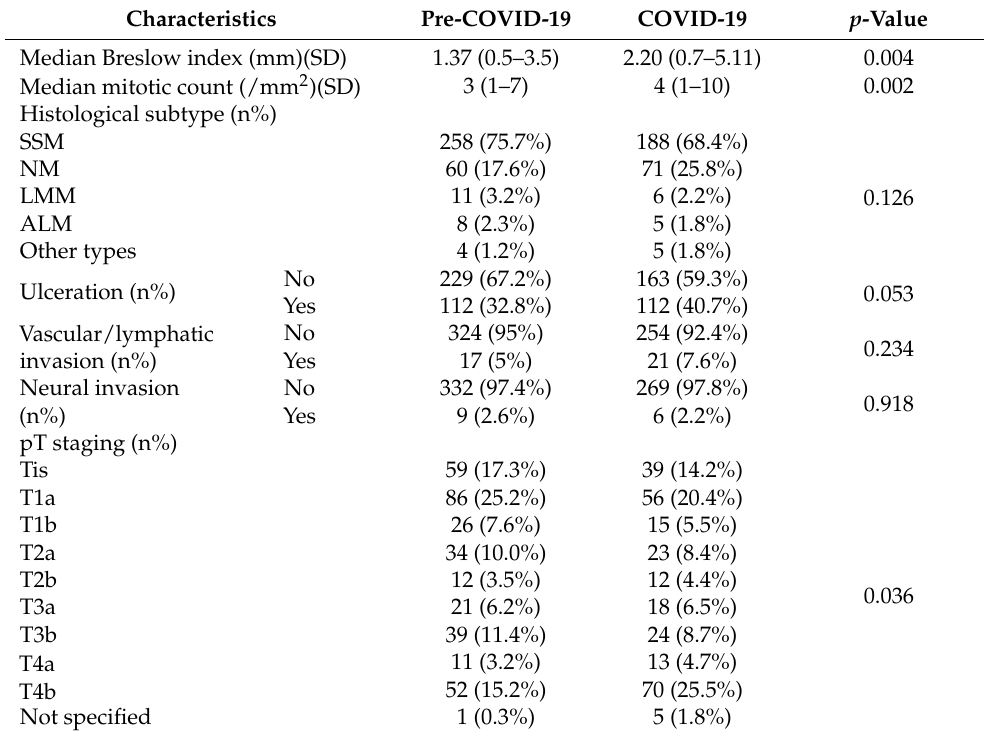
Table 2. Tumor characteristics in the two